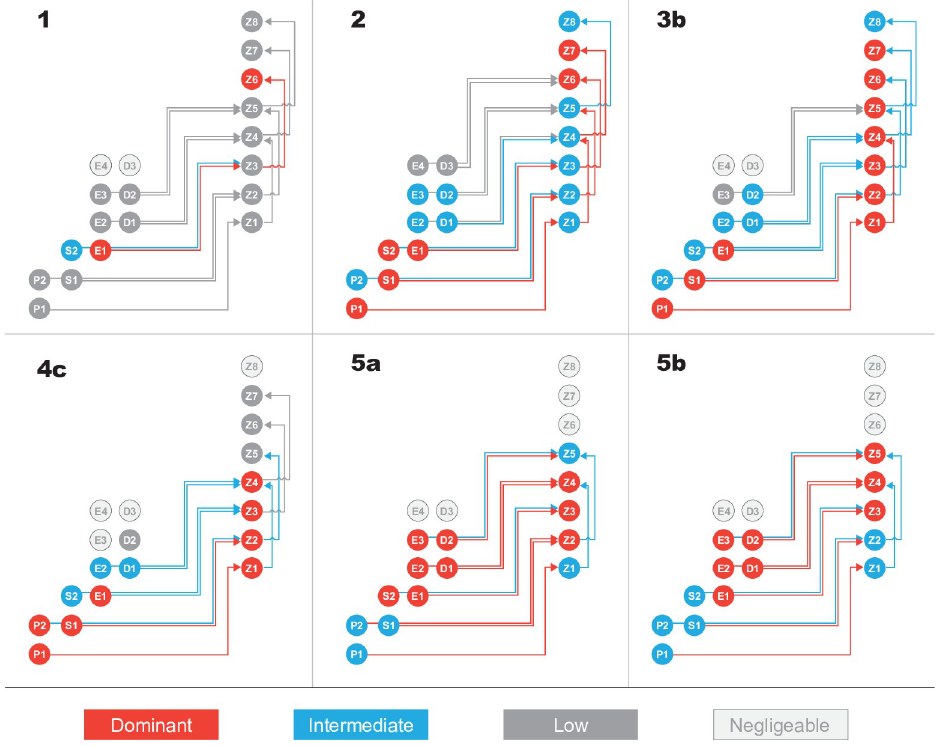
Fig 5. Simplified schematic representation of grazing and predation fluxes in the ecosystem model for grazing cases 1 to 5b. For each case, biomasses (circles) and fluxes (arrows) are color-coded as follows: Dominant in red, intermediate in blue, and low in dark grey. Negligible fluxes are not shown, and negligible biomasses are represented in light grey. See S1 and S2 Tables for detailed biomasses and grazing fluxes, respectively.